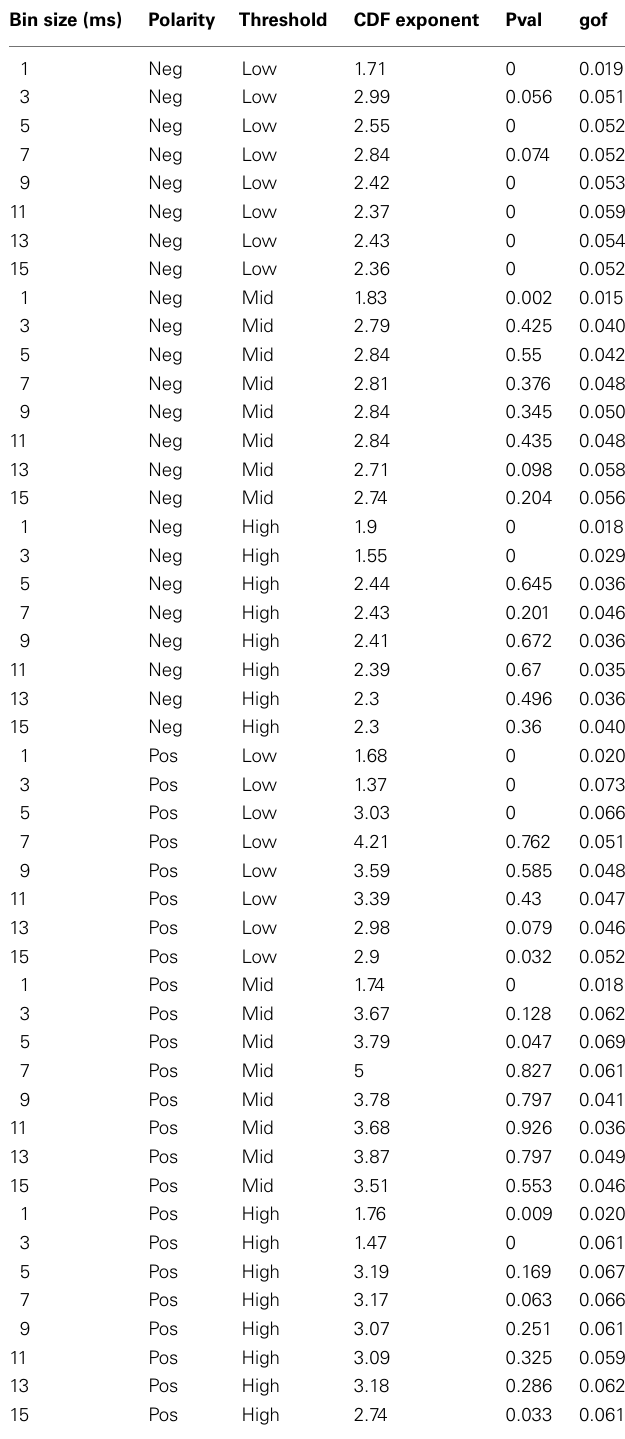
Table 3 | Detailed awake LFP